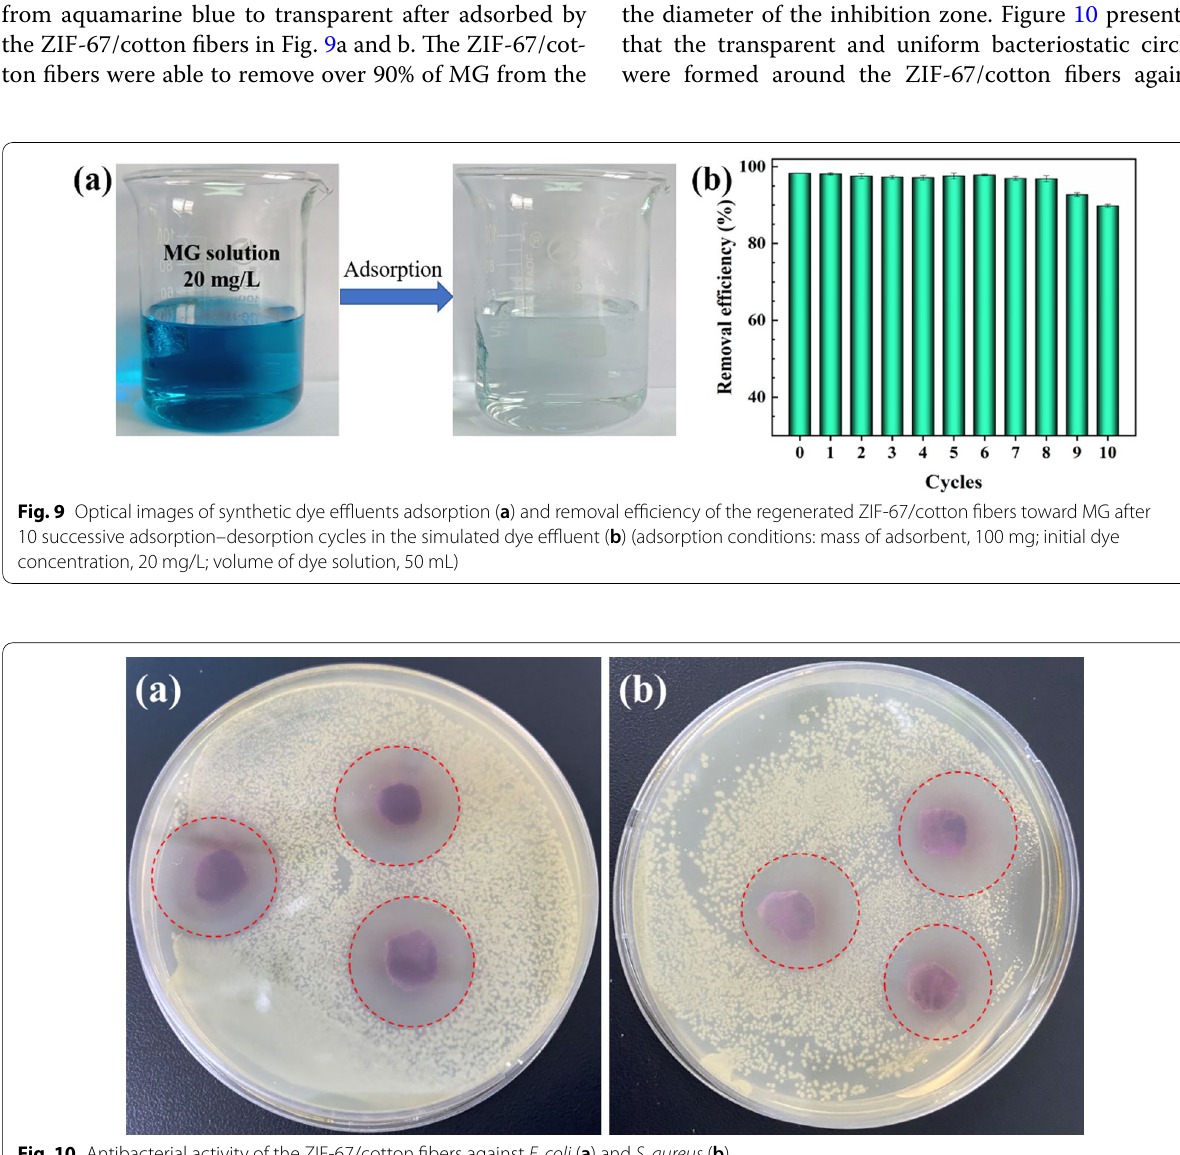
Fig. 10 Antibacterial activity of the ZIF-67/cotton fibers against E. coli ( a ) and S. aureus ( b